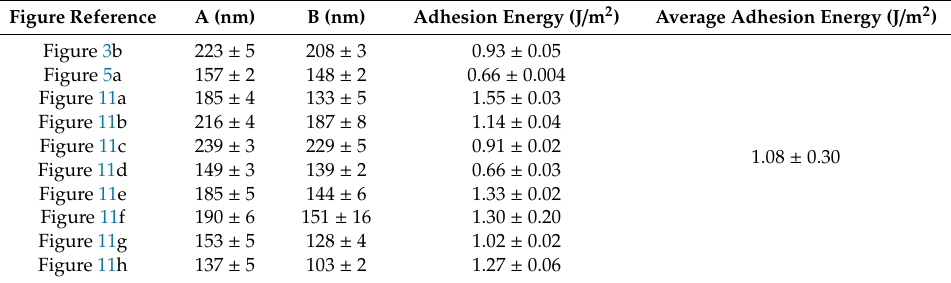
Table 1. Dimensions of truncated cubes and corresponding adhesion energies based on Equation